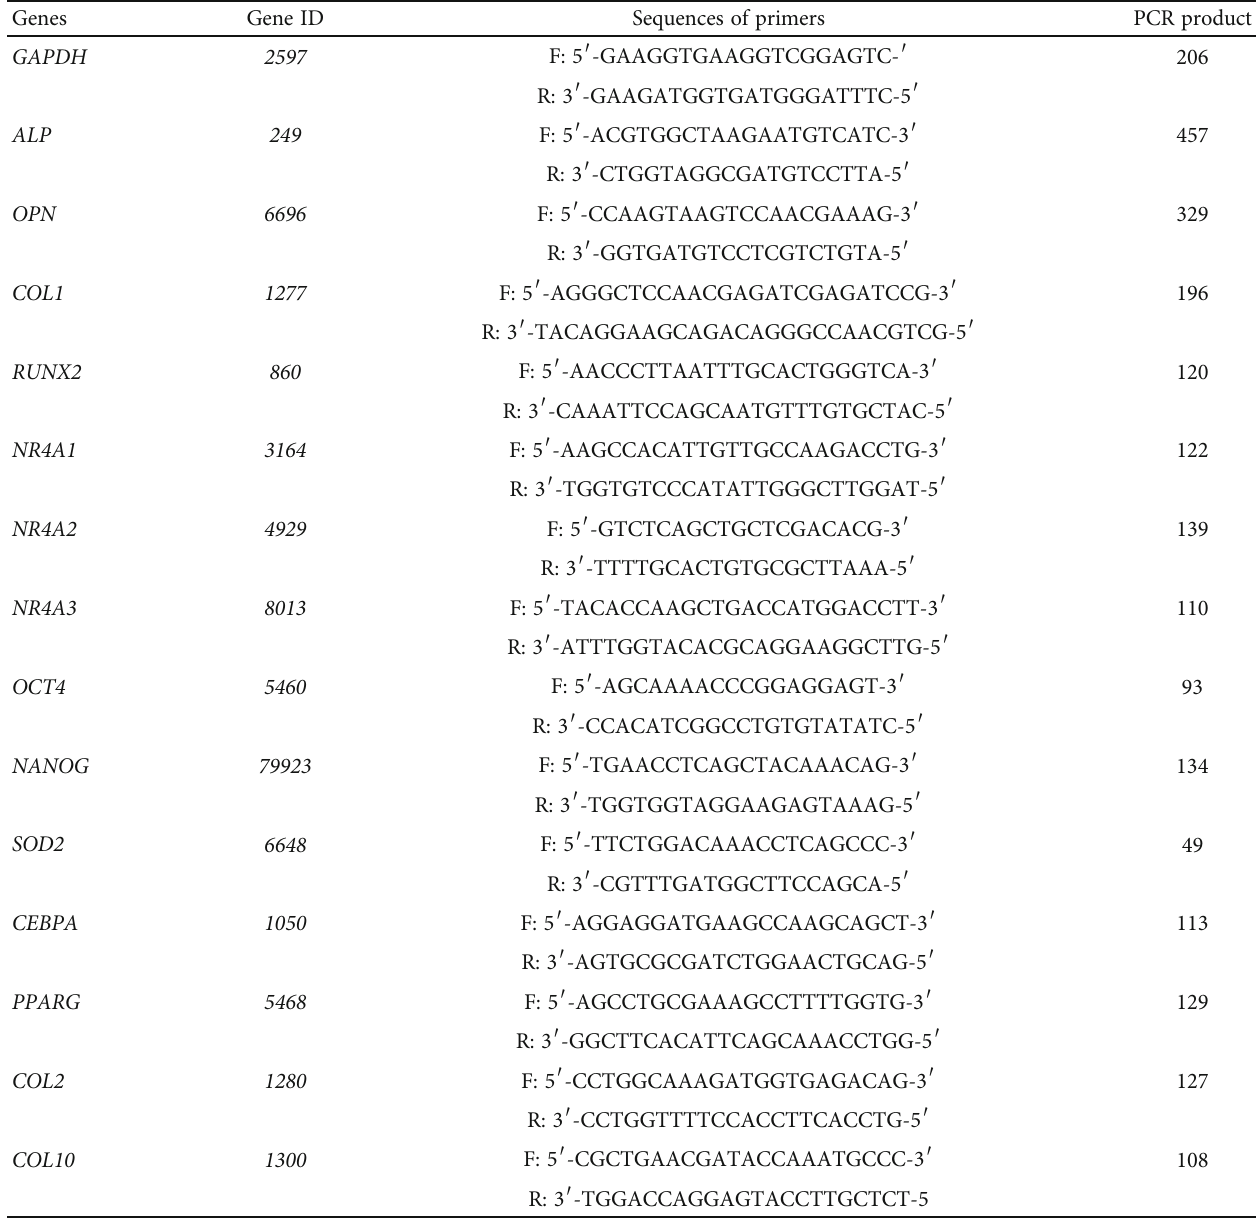
Table 1: Primer sequences for real-time